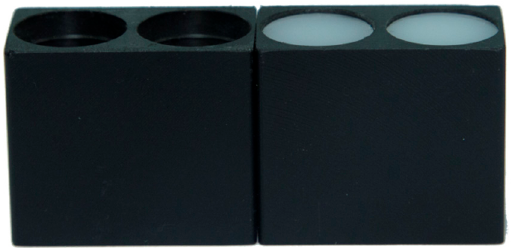
Figure 4. The lightweight structure used for the multispectral crop growth sensor.